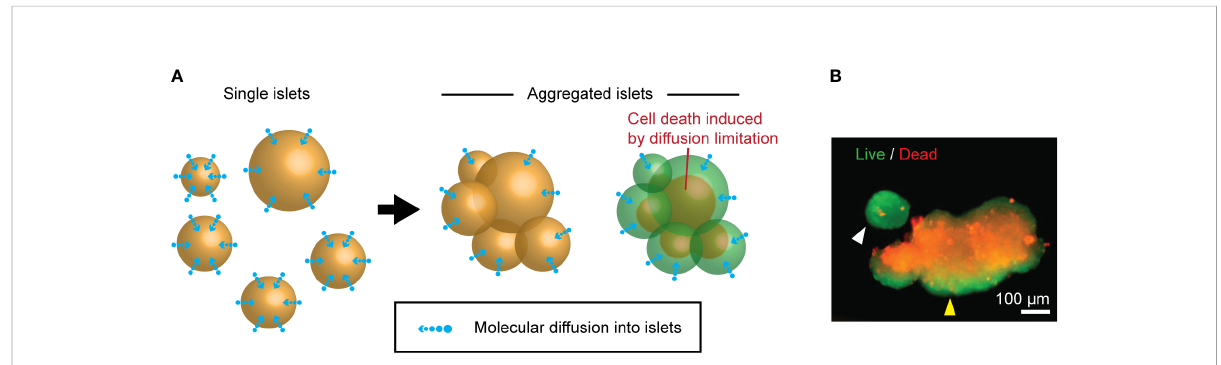
FIGURE 2 Islet death induced by the fusion during the culture. (A) A schematic of molecular diffusion: single islets (left panel) vs. fused islets (right panel). (B) A representative live (green color)/dead (red color) staining image of cultured human islets. Single islet (white arrowhead) and fused islets (yellow